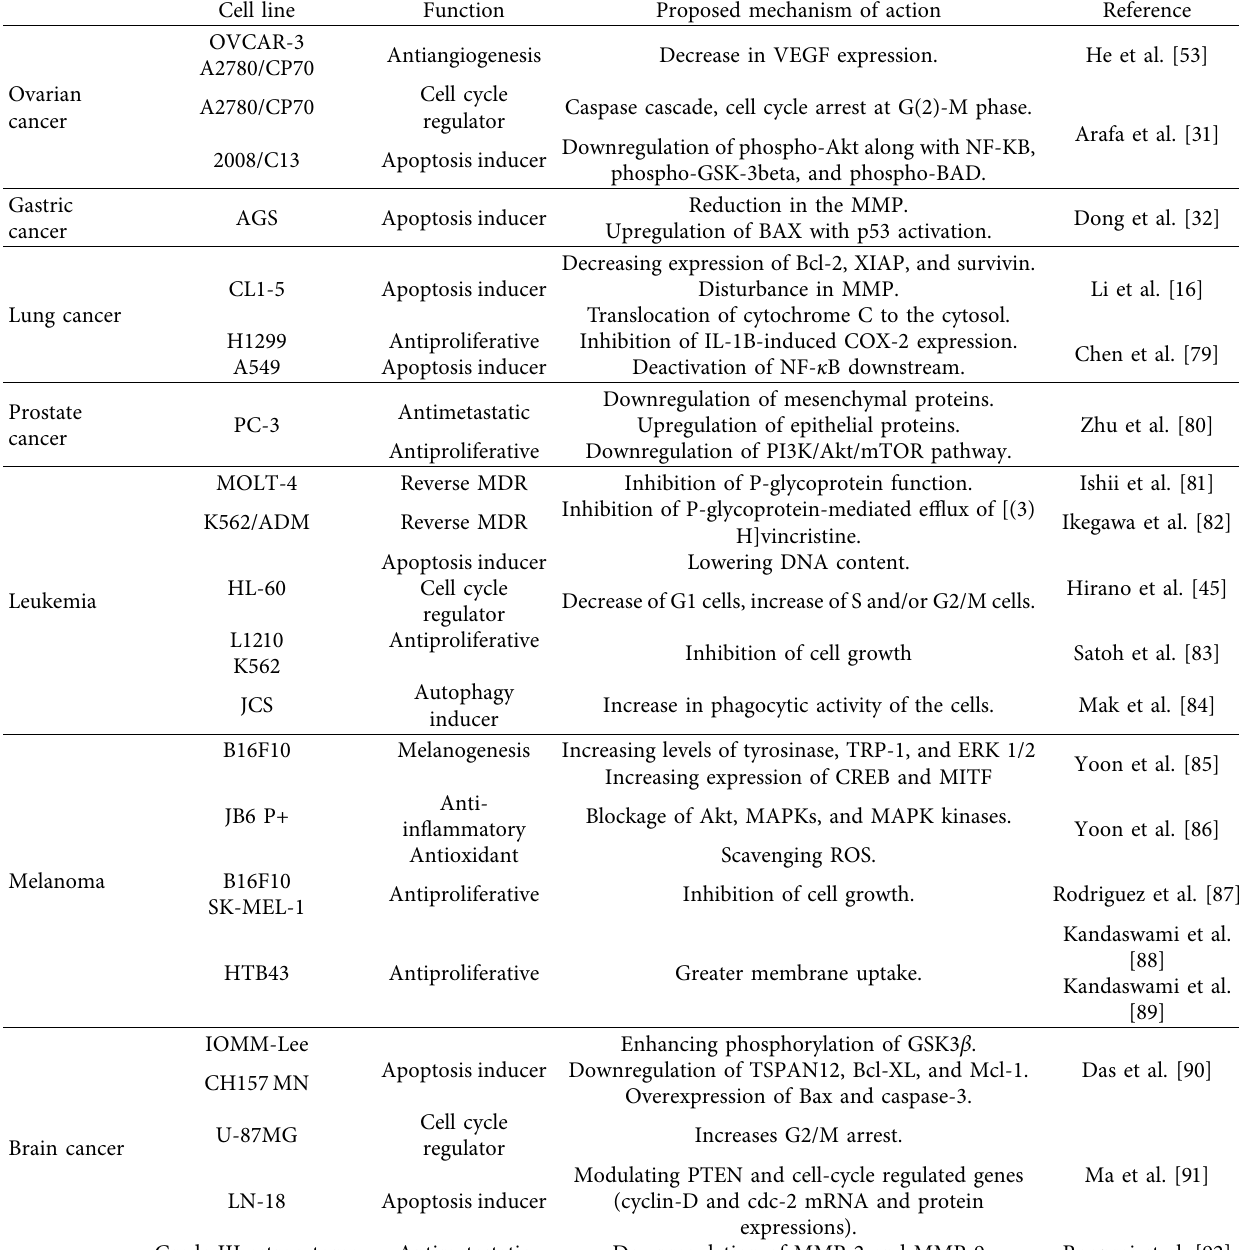
Table 1: Summary of the anticancer effects of